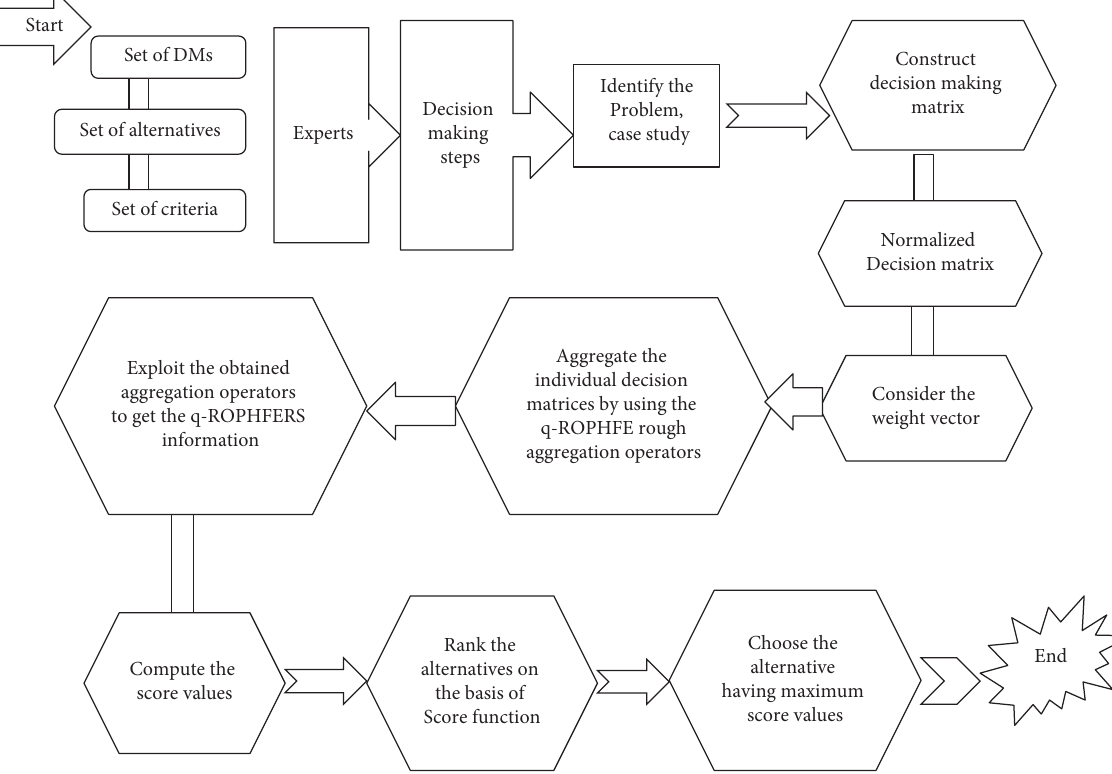
Figure 3: Algorithm steps for